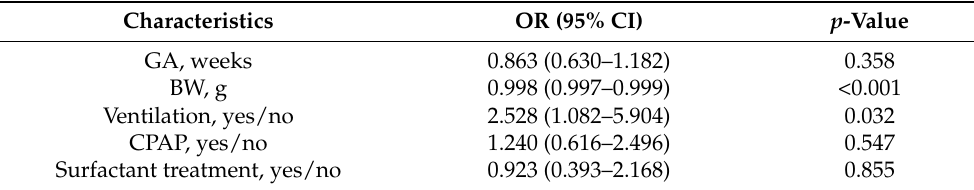
Table 4. Multivariate binary logistic regression analysis results. In contrast with univariate analysis of the same factors, only BW and ventilation were found to be significant risk factors for ROP (Stage 1–3).